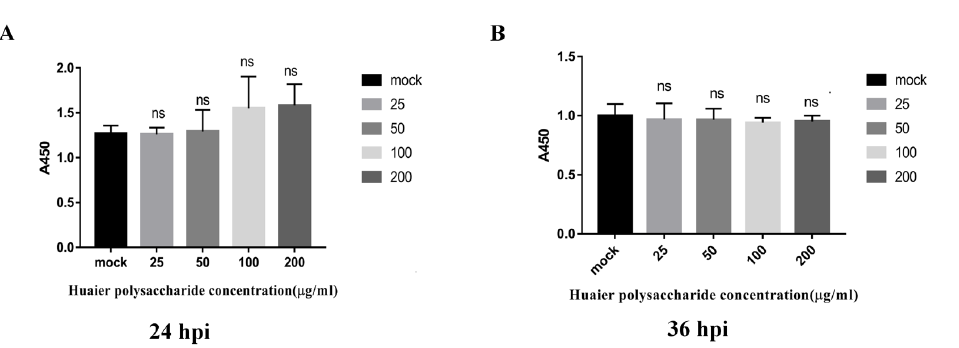
Figure 1. Huaier polysaccharide has no inhibitory effect on PK15 cells’ growth and apoptosis. ( A , B ) PK15 cells were pretreated with different concentrations of Huaier polysaccharide at 37 °C for 24 h or 36 h . Cell viability of PK15 cells was assessed with CCK-8 cell counting assays. ( C ) The apoptosis of PK15 cells treated or not with Huaier polysaccharide (200 mg/mL) was checked by flow cytome- try. Significance was analyzed using the one-tailed Student’s t -test. Data are shown as mean ± SD based on three independent experiments. “ns” is not significant. 3.2. Huaier Polysaccharide Inhibis PRV XJ5 Infection in PK15 Cells Figure 1 reveals that Huaier polysaccharide had no effect on PK15 cells’ growth. To investigate the role of Huaier polysaccharides in preventing PRV XJ5 infection, PK15 cells were treated as described in Section 2.3.2. PRV XJ5 (MOI = 0.1) infection resulted in an obvious cytopathic effect (CPE) in the PK15 cells (Figure 2A), which could be inhibited by Huaier polysaccharide, especially at the concentrations of 100 and 200 μg/mL. The antivi- ral effect of Huaier polysaccharide against PRV XJ5 was further demonstrated through Western blot analysis. gB is a protein that is essential for PRV replication [28]. Thus, we assessed the change in gB expression. The results indicated that the PRV gB protein ex- pression level was reduced after Huaier polysaccharide treatment, with an inhibition rate of 73–94%, at 100 and 200 μg/mL concentrations (Figure 2B,C). The supernatant of the infected PK15 cells was collected to determine the viral titer in terms of the 50% tissue culture infective dose (TCID 50 ). As expected, TCID 50 analysis showed that the Huaier pol- ysaccharide treatment reduced the production of virions; 200 μg/mL Huaier polysaccha- ride displayed the inhibition rate of 99.9% (Figure 2D). Furthermore, the immunofluores- cent assay (IFA) confirmed that Huaier polysaccharide treatment inhibited PRV XJ5 infec- tion in a dose-dependent manner, with the inhibition rate of 13% (25 μg/mL)–99.6% (200 μg/mL) (Figure 2E). qRT-PCR analysis indicated that Huaier polysaccharide decreased the viral DNA copies of PRV XJ5 (Figure 2F). In addition, we explored the effect of Huaier polysaccharide on PRV NT and PRV Ra by qRT-PCR. qRT-PCR analysis revealed that Huaier polysaccharide decreased the viral DNA copies of PRV NT (Figure 2G) and PRV Ra (Figure 2H). The purpose of the infective assay experiment was to emphasize that